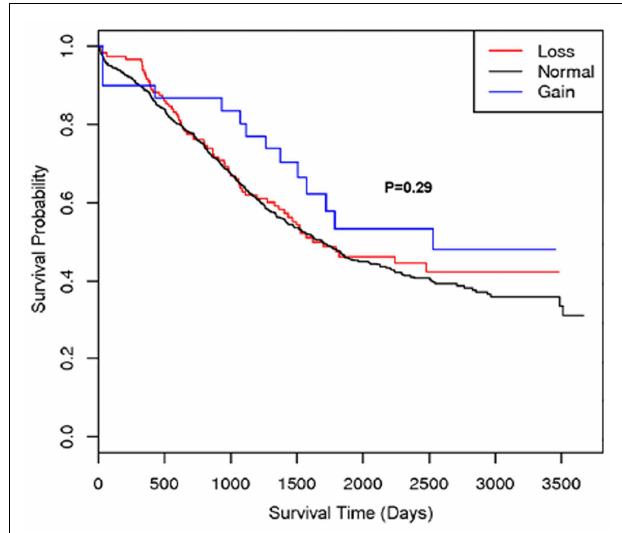
FIGURE 2 | Kaplan–Meier plot of the 22q13 CNV association with ovarian cancer survival. The different lines represent the survival curve for subjects with a “loss,” “gain,” or “normal” for the genomic segment.